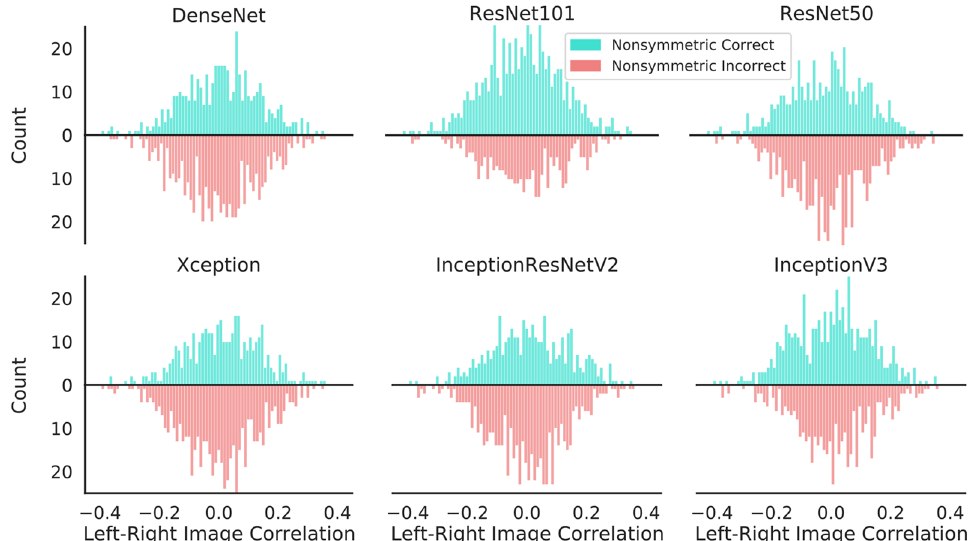
Figure 4. Analysis of misclassifications depending on the degree of non-symmetry. We assess the performance of the DNNs on non-symmetric images depending on their degree of non-symmetry. To obtain the degree of non-symmetry, we evaluate the correlation between left and (flipped) right image flanks. We plot the number of images correctly or incorrectly classified depending on such degree of non-symmetry, for images of band size 14. Results indicates that for all DNNs, the probability score assigned to a non-symmetric image is independent of the degree of